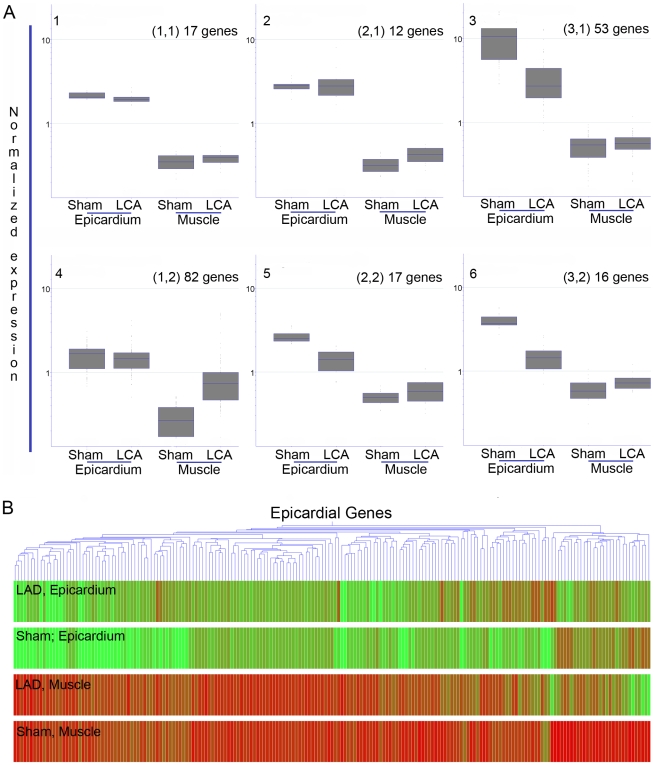
Unsupervised analysis of epicardial gene expression post infarction.A) Self- organizing maps were used to derive six clusters two of which, (3 and 4) contain genes that are strongly regulated. Cluster 3, includes epicardial signature genes whose expression decreases sharply in the epicardium but remains low in muscle post-infarction. Cluster 4 contains epicardial signature genes that are largely unchanged in the epicardium but are increased in muscle post-infarction. B) Heat map of data in A).